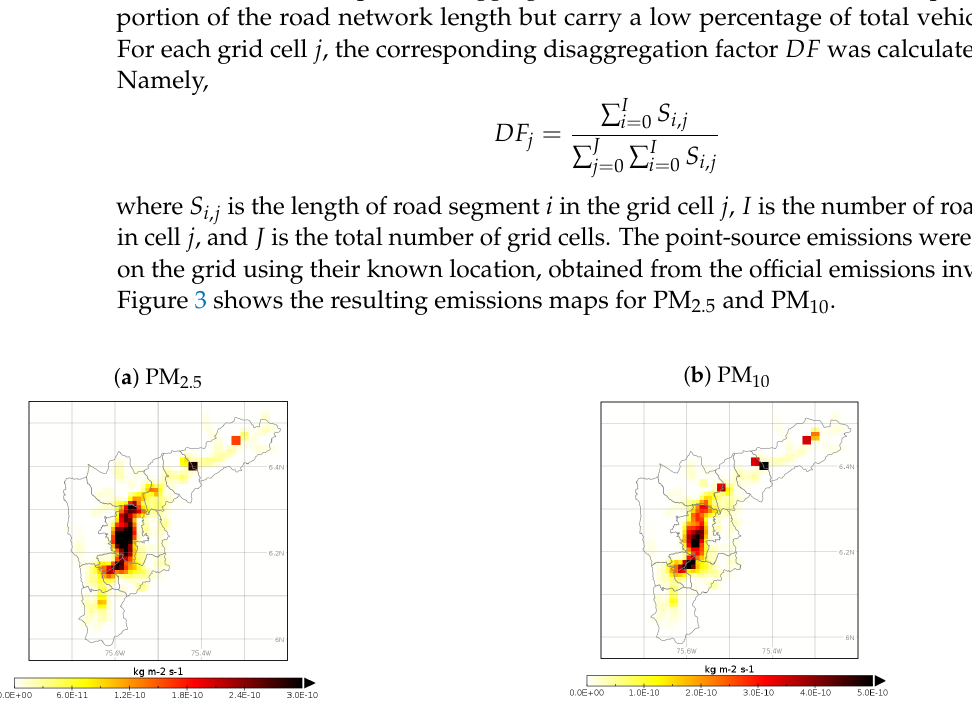
Figure 3. Local particulate matter emission inventories for the Aburrá Valley: ( a ) PM 2.5 , and ( b ) PM 10 . The values correspond with the estimated annual